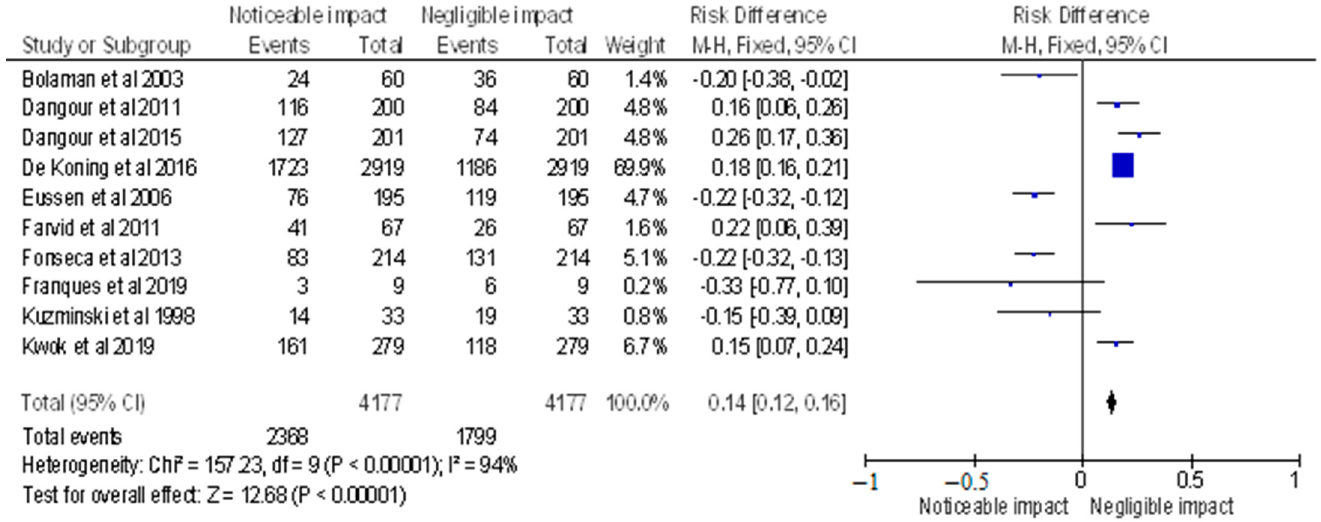
Figure 3. Risk difference of selected randomised control trials represented on a forest plot after their meta-analysis, in which the noticeable impact of Vitamin B12 interventions compared to their negative to negligible impact was assessed (where the blue dot represents the study with the most weight and the rhombus represents the total weight of the forest plot).